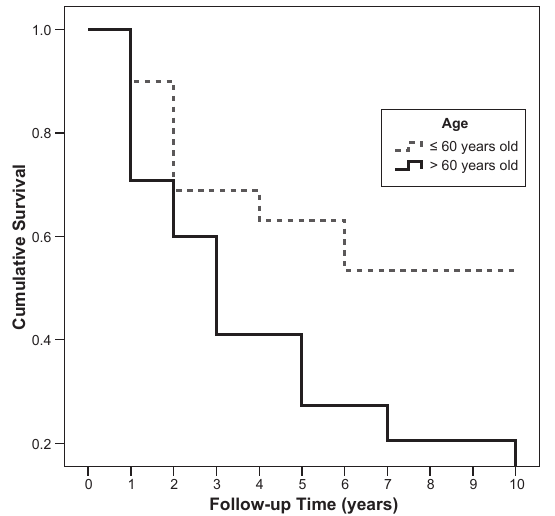
Figure 4 - Mortality and Kaplan-Meier curves with uni- variate significance determined by the log-rank test, per- formance status predictor, for subjects with DLBCL of the OC-MR, seen at the A.C. Camargo Hospital for Cancer, between January 1980 and December 2005.